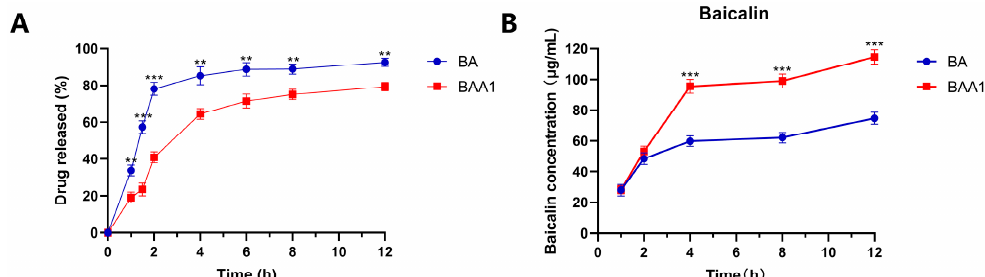
Figure 2. Cumulative percentage drug release and cellular uptake from BA and BAA1. ( A ) Cumula- tive percentage drug release from free BA and BAA1. ( B ) The cellular uptake of BA and BAA1 in HepG2 cells. Data are mean ± SD, n = 3; ** p < 0.01, *** p <